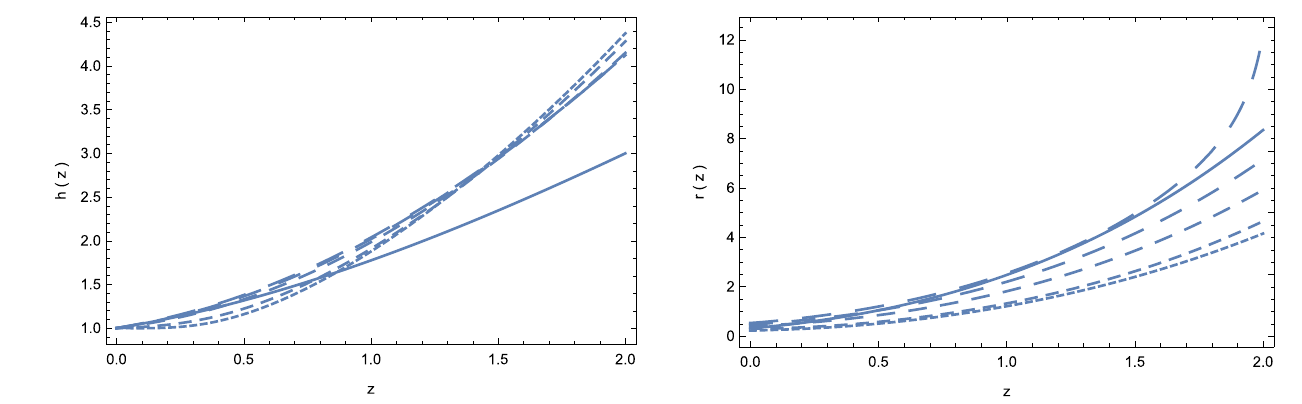
(cid:12) (cid:11) ˜ Q , ˜ T = α ˜ Q ˜ T